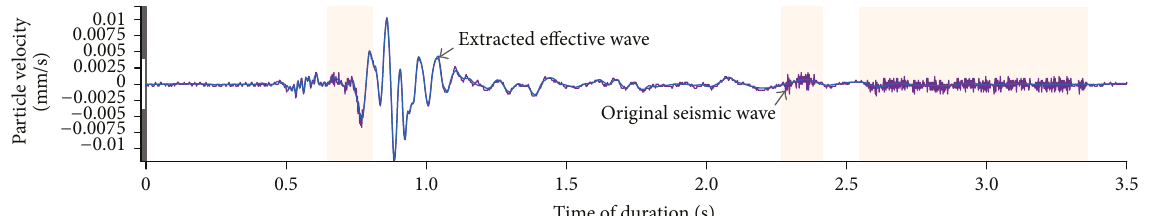
Figure 10: Pure microseismic waveform reconstructed via the effective wave component extracted from the original measured wave sw12.